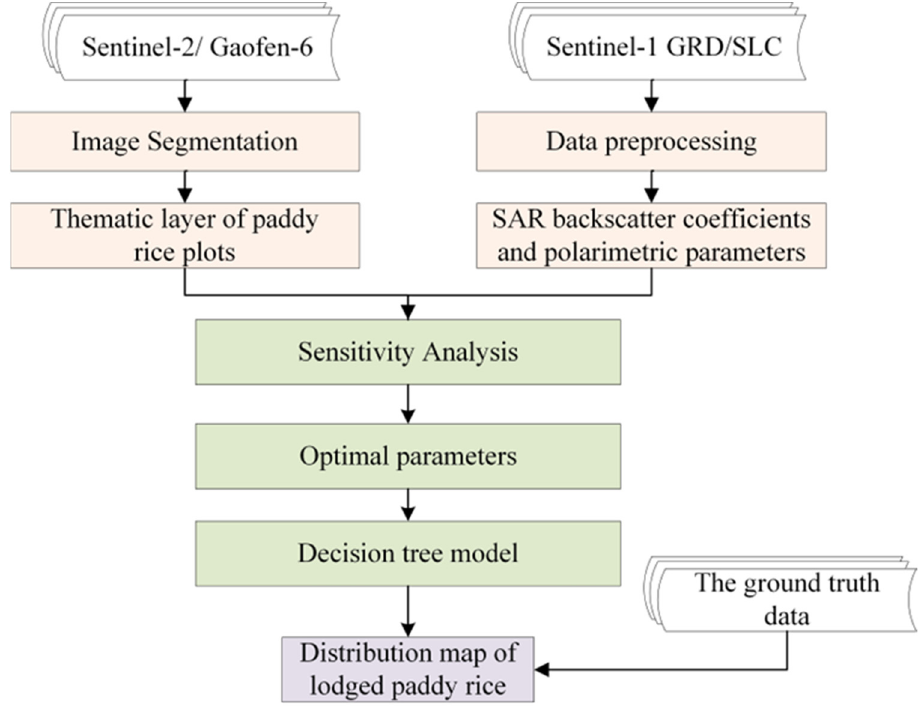
Figure 4. Methodological flowchart for extracting the distribution map of lodged paddy rice using remote-sensing imagery.